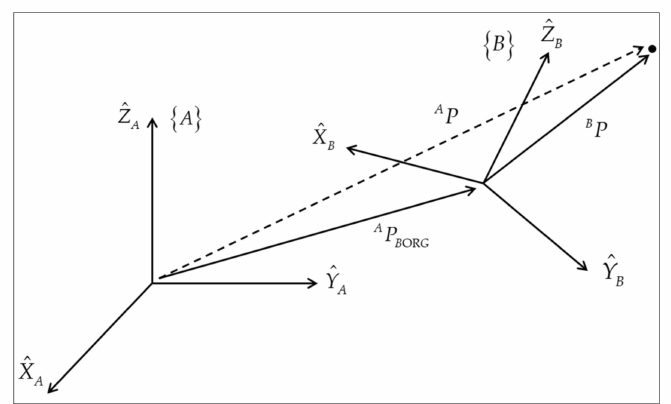
Figure 2. Rotation and displacement between the coordinate systems { A } and { B